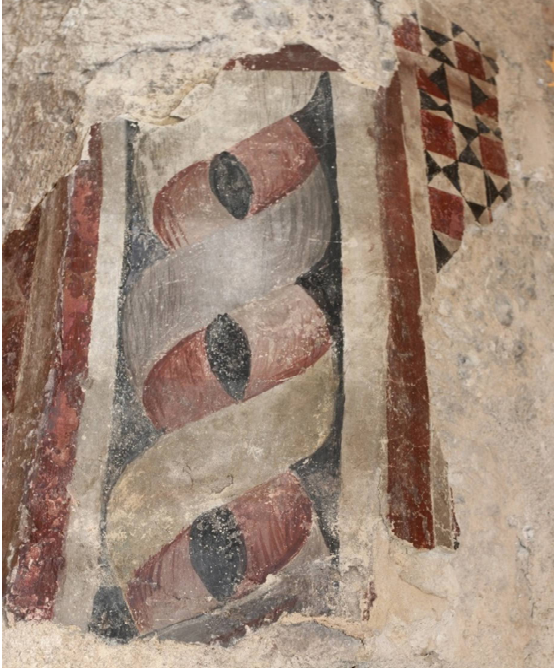
Figure 6. Karlštejn, relic of painted decoration on the triumphal arch of the chapel of St. Nicholas.